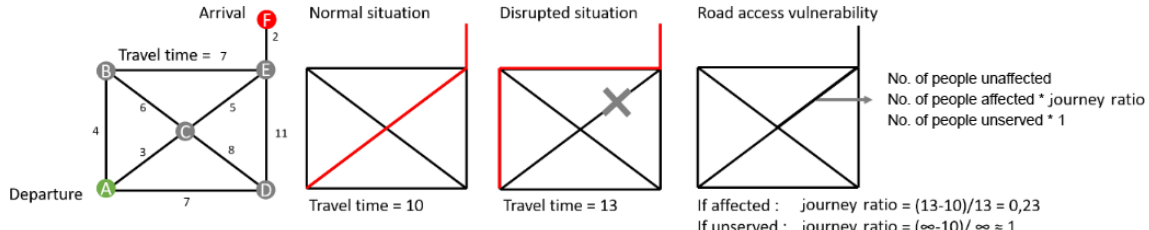
Figure 4. Accessibility assessment before and after a disruption using Dijkstra’s shortest-path algorithm. People affected and unserved are weighted by the journey ratio which assesses the travel time increase caused by the disruption and